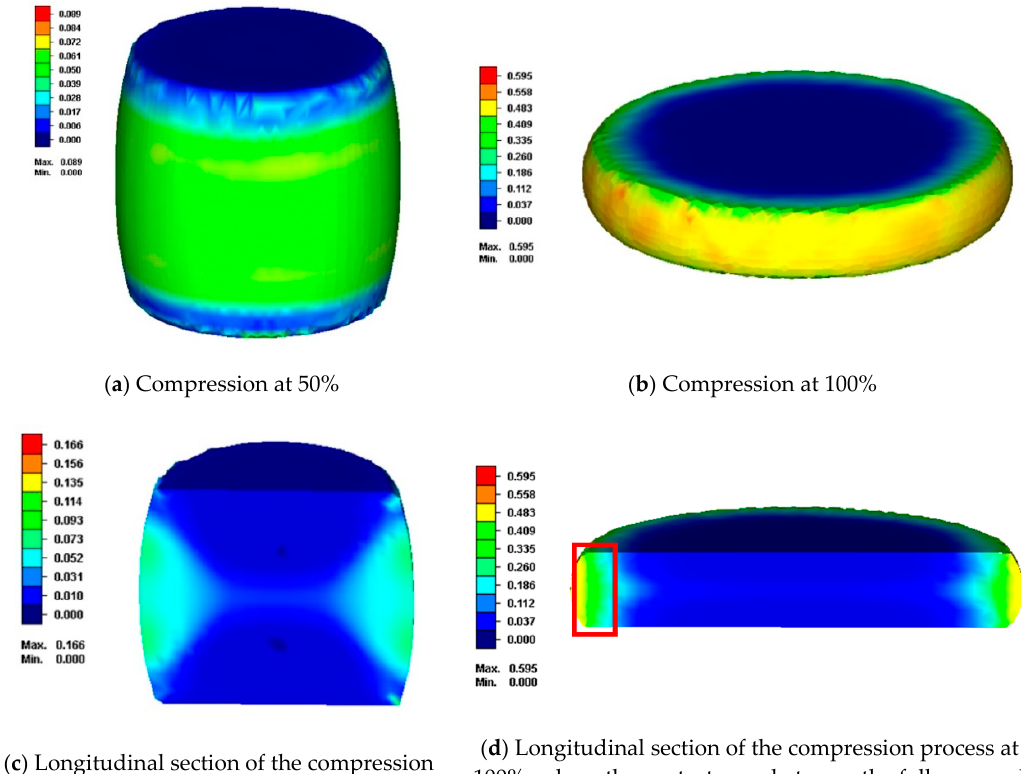
Figure 8. Damage distribution during the manufacturing process of disks.